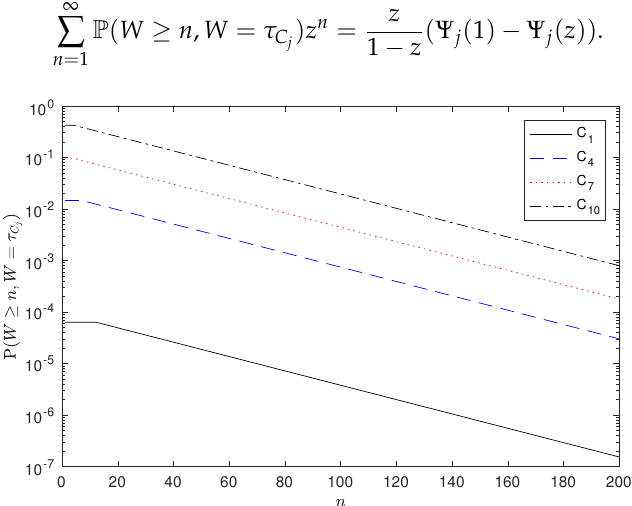
) when j = 1,4,7,10 for Example 1. j ) , j = 1, . . . ,10 for Example j